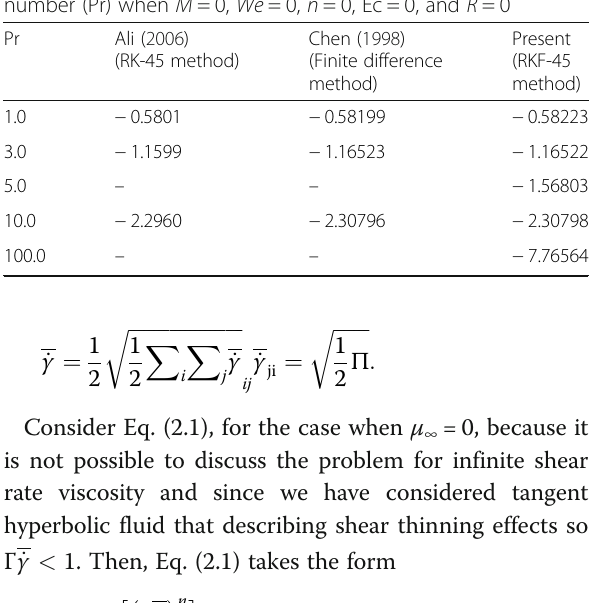
Table 2 Comparison of − θ ′ (0) for different values of